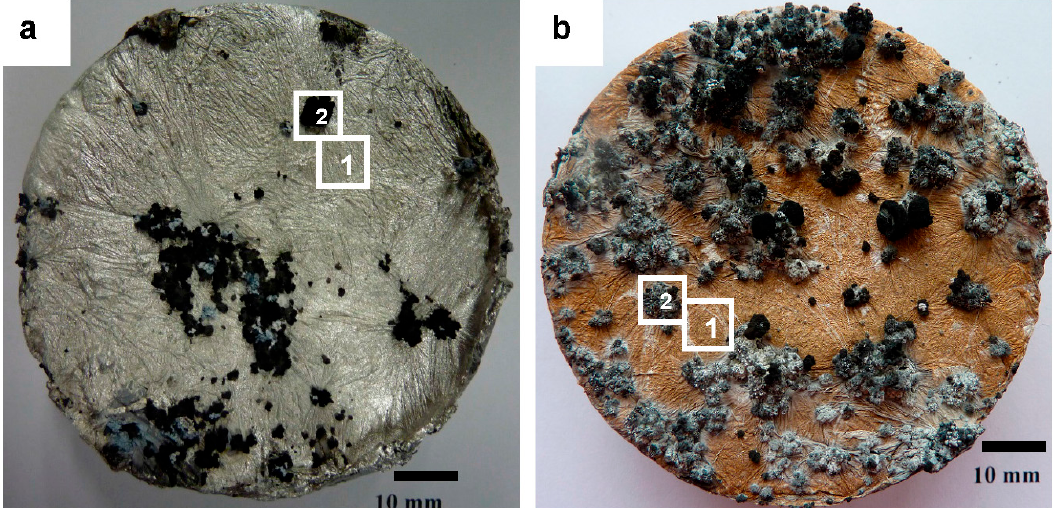
Figure 2. Macroscopic view of surface of Mg alloys exposed to air under two oxidation conditions: ( a ) AJ62 alloy held at 690 °C for 10 s, reprinted with permission from Reference [42], copyright 2014, Taylor & Francis Ltd., www.tandfonline.com; ( b ) AZ91D alloy held at 650 °C for 10 s, reprinted with permission from Reference [44], copyright 2014, Taylor & Francis Ltd., www.tandfonline.com. Marked regions indicate following reaction stages: (1) non ‐ nodular growth in layer manner and (2) nodular growth. AJ62 alloy exhibited higher resistance to high temperature oxidation than that of AZ91D alloy.